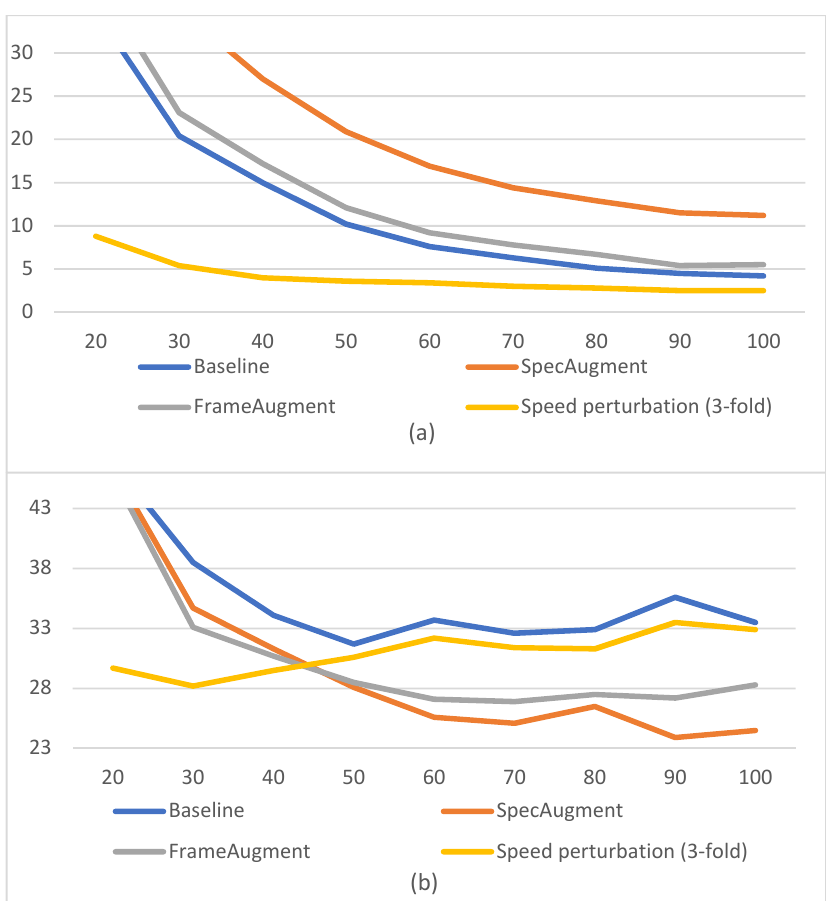
Figure 10. Attention loss L Attention of the training data ( a ) and validation data ( b ) of the LibriSpeech database. The horizontal axis denotes the number of epochs, and the vertical axis denotes L Attention . We note that 3-fold speed perturbation means 3 times the original training data.